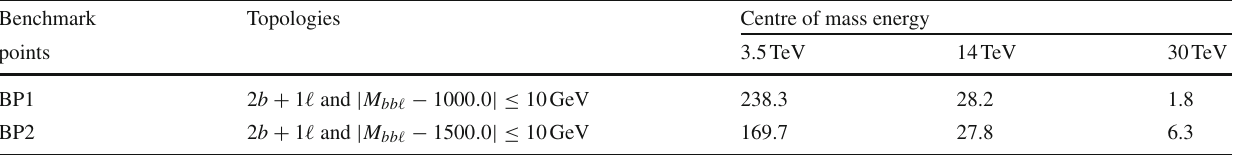
Table 16 The number of events in M bb (cid:5) distribution after the window cut around the mass peak for the benchmark points at the muon col- lider with the centre of mass energies of 3.5TeV, 14TeV and